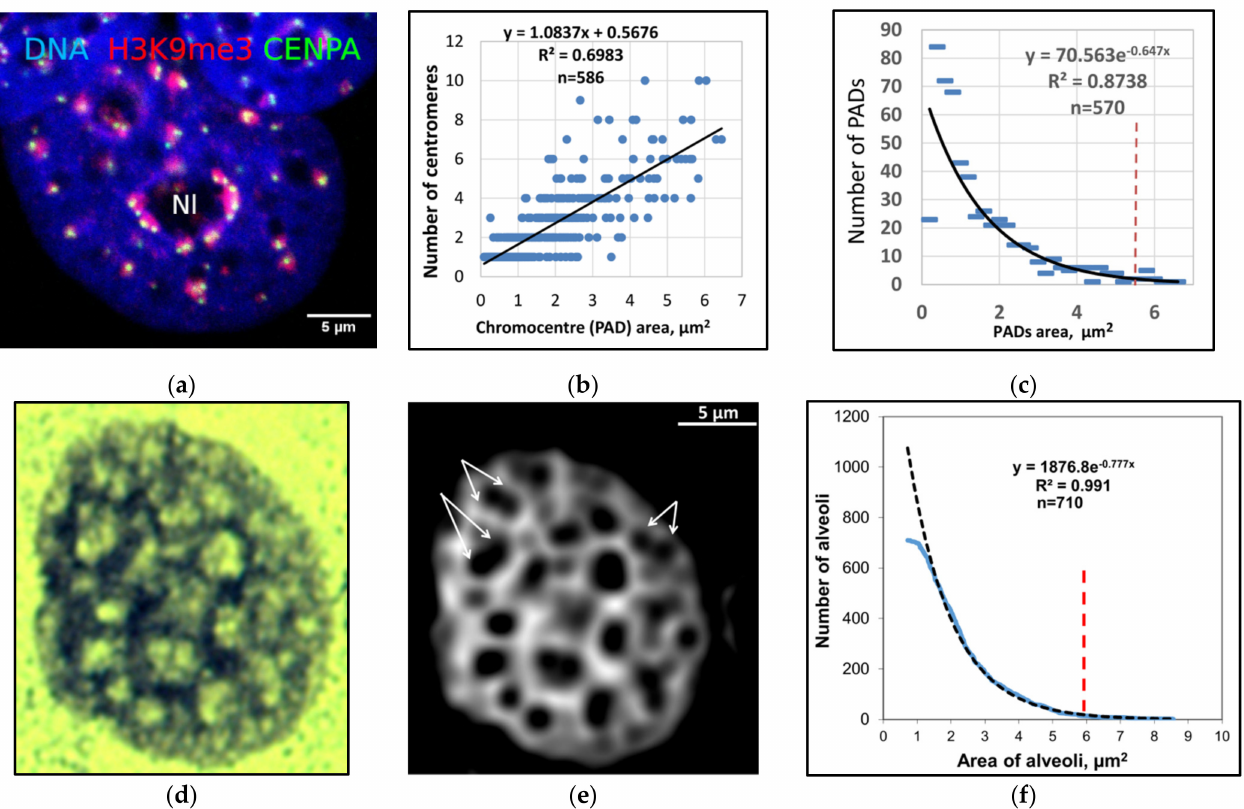
Figure 3. The features of PADs and their network show a scale-free distribution in control MCF7 cells. ( a , b ) H3K9me3- positive PADs are clustered by centromeres, Nl—nucleolus; ( c ) the area and number of individual PADs clustered by centromeres and the negative exponential relationship between the area and number of individual PADs, with the dashed boundary of the largest likely static PADs; ( d ) preferential staining of heterochromatin by toluidine blue (method from [61]); ( e ) the filtered image of the same nucleus revealed the heterochromatin network with typical double alveoli (double- arrowed); ( f ) the negative exponential relationship between the area and the number of individual network alveoli with a set dashed boundary for the largest ones; ( a – c ) republished from